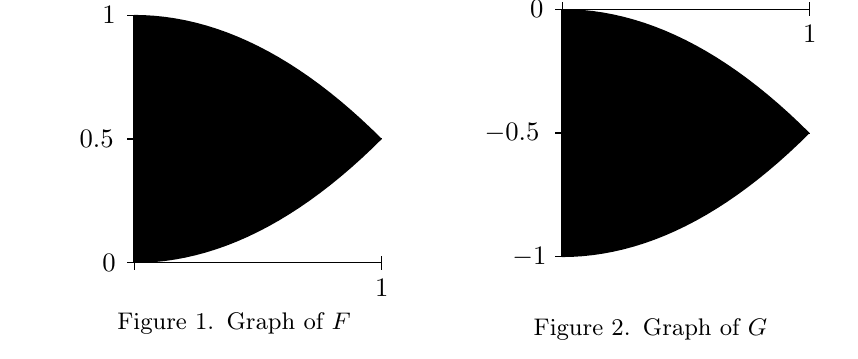
Figure 1. Graph of F Figure 2. Graph of